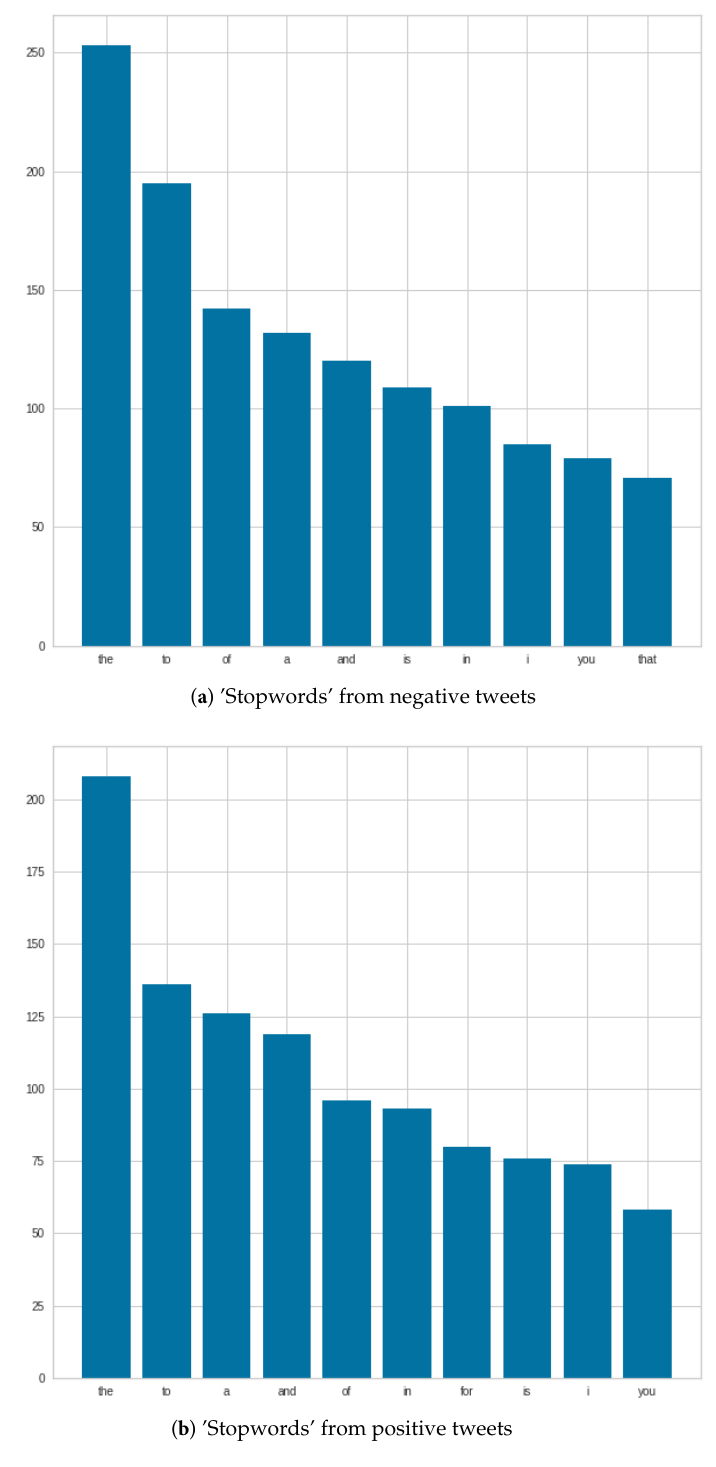
Figure 8. Negative and positive ‘Stopwords’. The time period stands between 2 September 2021